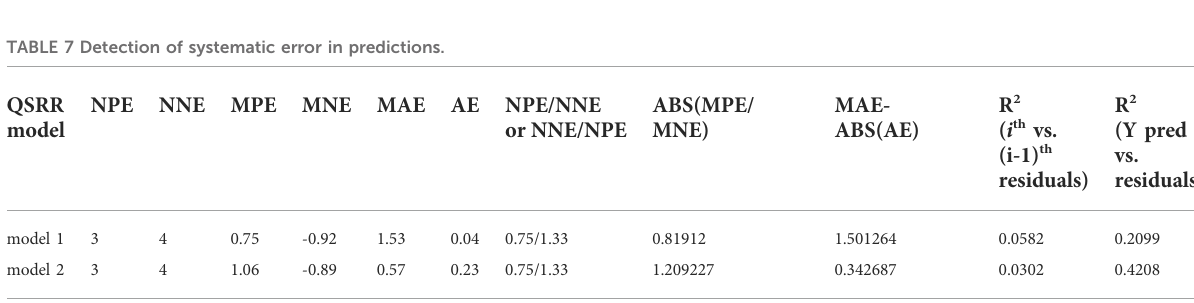
TABLE 7 Detection of systematic error in predictions.